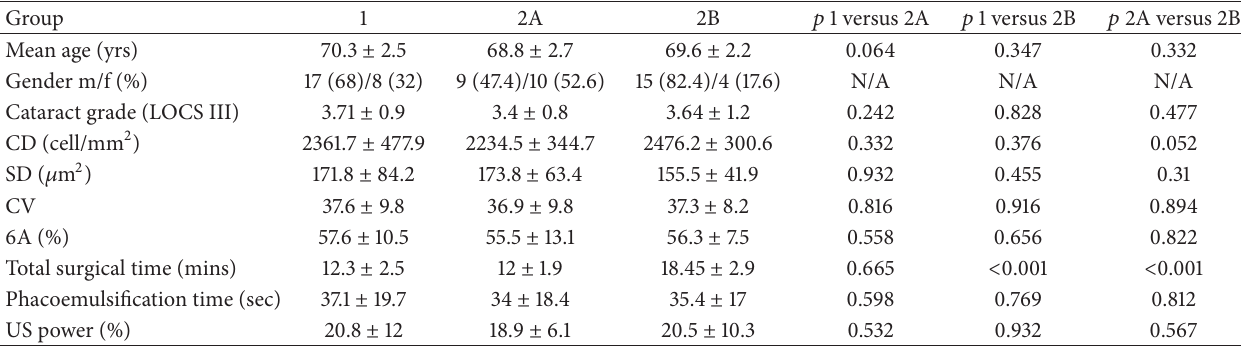
Table 1: Preoperative demographic and operative data of the patients (mean ± standard deviation; LOCS: lens opacity classification system; CD: cell density; SD: standard deviation; CV: coefficient of variation; 6A: hexagonality coefficient; US: ultrasound; 𝑝 : 𝑝 value; N/A: not